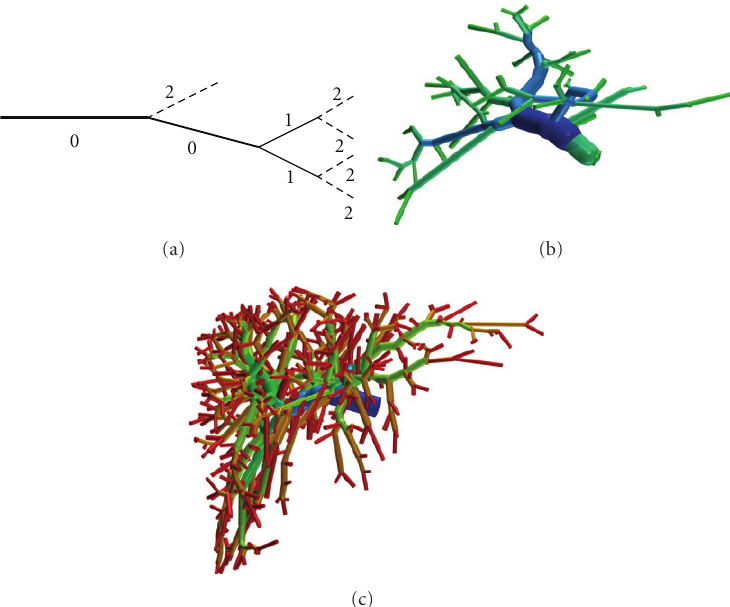
Figure 2: The (a) sketch shows the definition of Strahler ∗ orders: the order decreases towards the root if two edges of the same order meet, else the minimum is used, and the values are shifted such that the root edge has order 0. Images (b) and (c) show Strahler ∗ orders (HSV color coded from blue = 0 to red = 5) for two of the clinical PV data